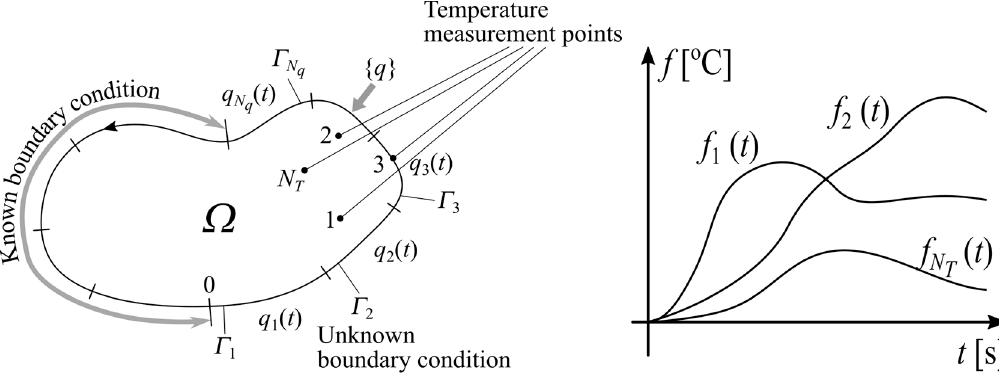
Figure 3. An inverse problem with additional measured temperature histories.